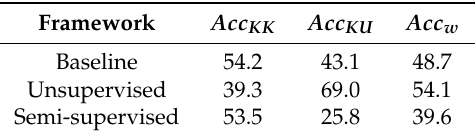
Table 7. Results(%) of the proposed frameworks using DCASE (Detection and Classification of Acoustic Scenes and Events) 2019 Task 1C dataset. The baseline results correspond to the one presented by the task organization as a starting